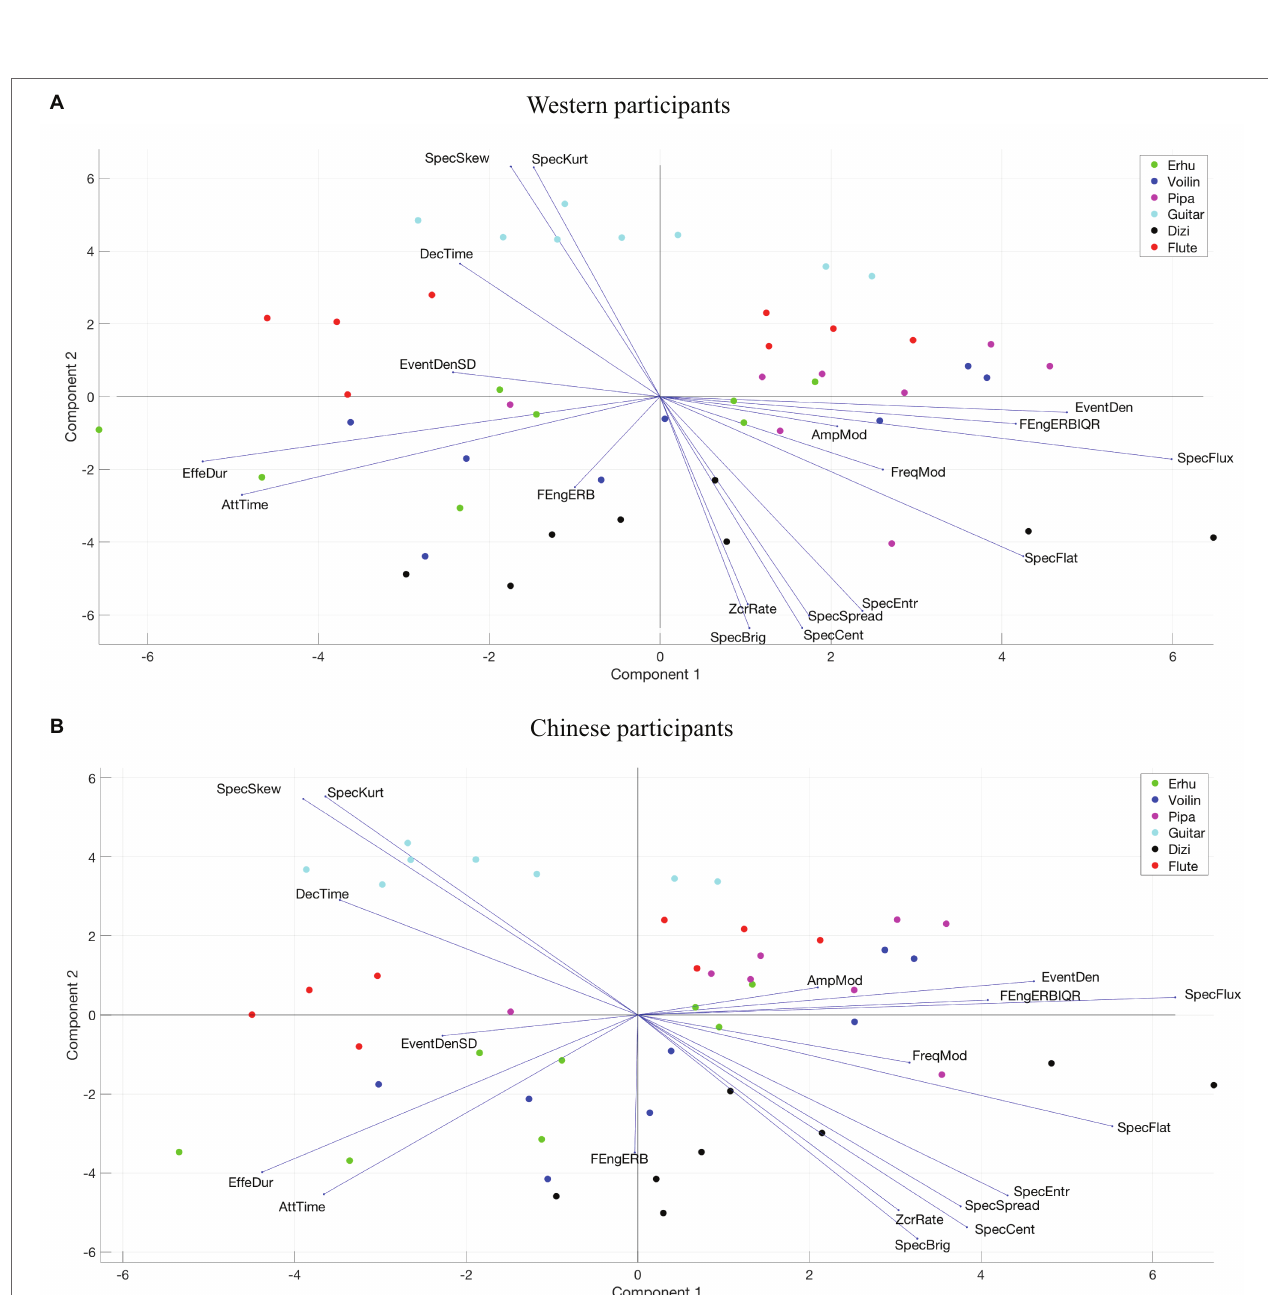
FIGURE 8 | Loadings and scores across two PCs of PLSR for valence. (A) Western participants. (B) Chinese participants.